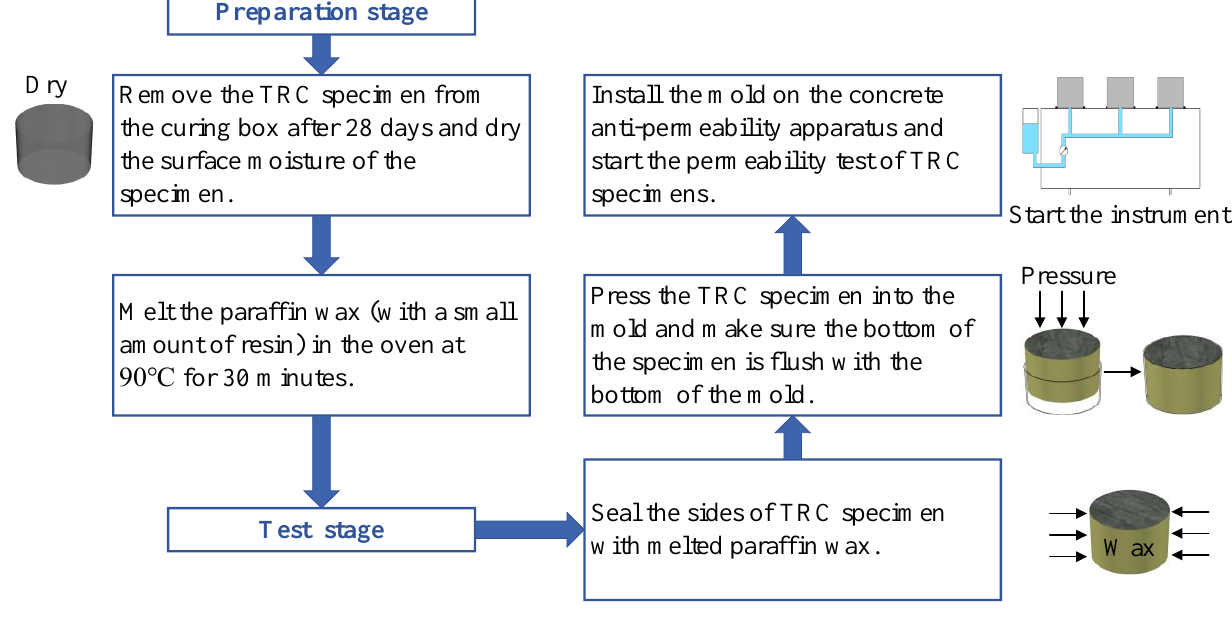
Figure 4. Flow chart of concrete permeability test.